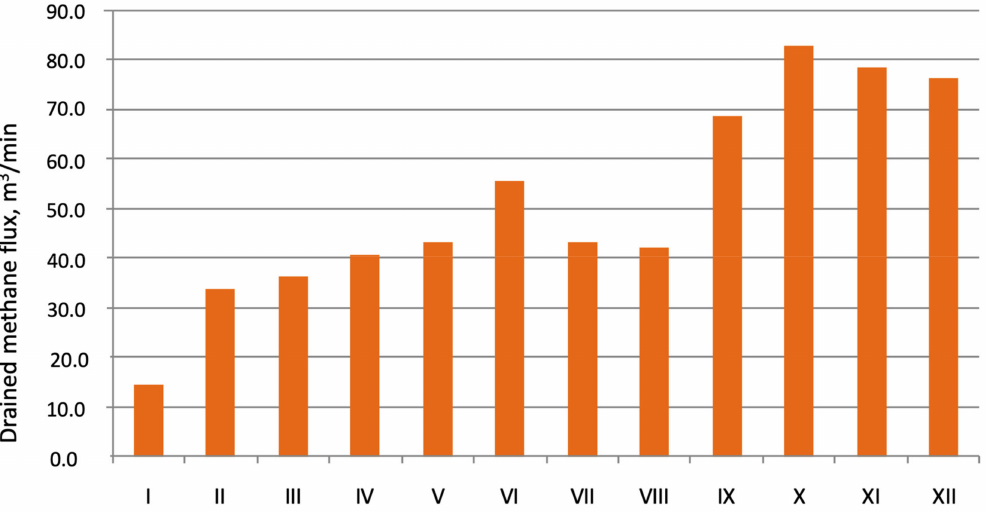
Figure 11. Methane capture in the longwall B-15 seam